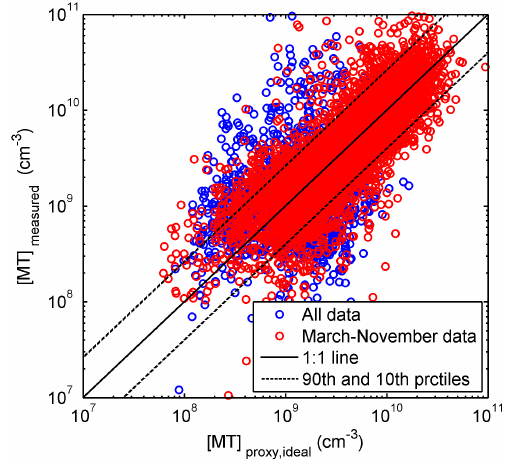
Figure 2. The correlation between the measured monoterpene con- centration and concentration predicted by MT proxy , ideal , which is calculated by using the measured monoterpene concentration for determining the concentration of NO 3 . The blue circles show all data, and the red circles show data for March–November. The solid black line shows the 1 : 1 line and the dotted black lines show 90th and 10th percentiles of the ratio between the measurements and proxy. The variability V 90 / 10 is calculated as the ratio of the 90th and 10th